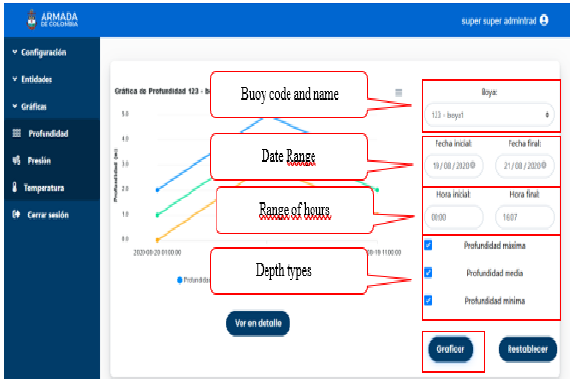
Figure 4. Buoys’ graphs.